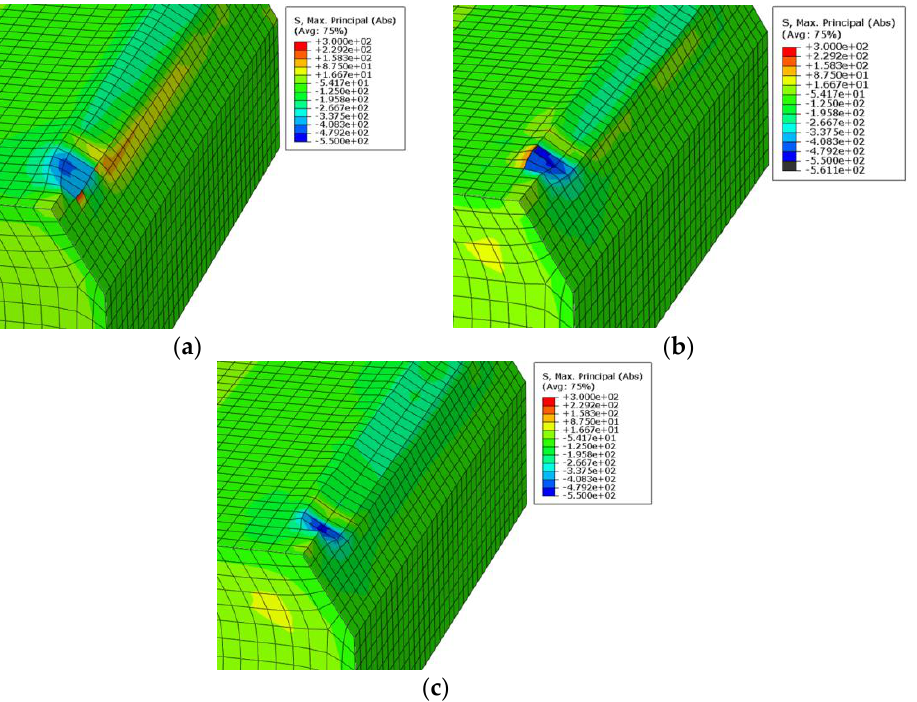
Figure 15. Stress on a slab corner under two-chamfered rolling process. ( a ) Horizontal rolling; ( b ) vertical rolling; ( c ) frontal rolling using a two-roller.